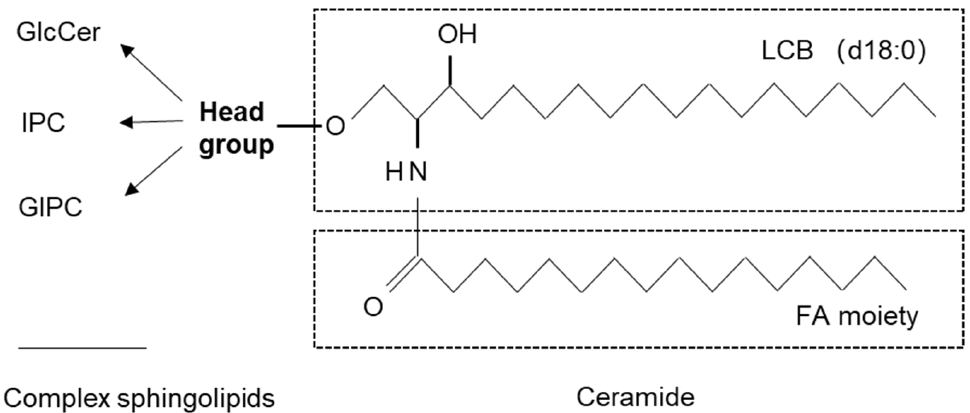
Figure 1. A diagram of sphingolipid structure. LCBs present as saturated form (18:0) or desaturated form (18:1) with 2/3 OH (d/t) numbers. The fatty acid (FA) chain has various carbon numbers ≥ 16. Ceramide is the simplest sphingolipid form. Head group indicates the substituents that are combined with ceramides to form complex sphingolipids.